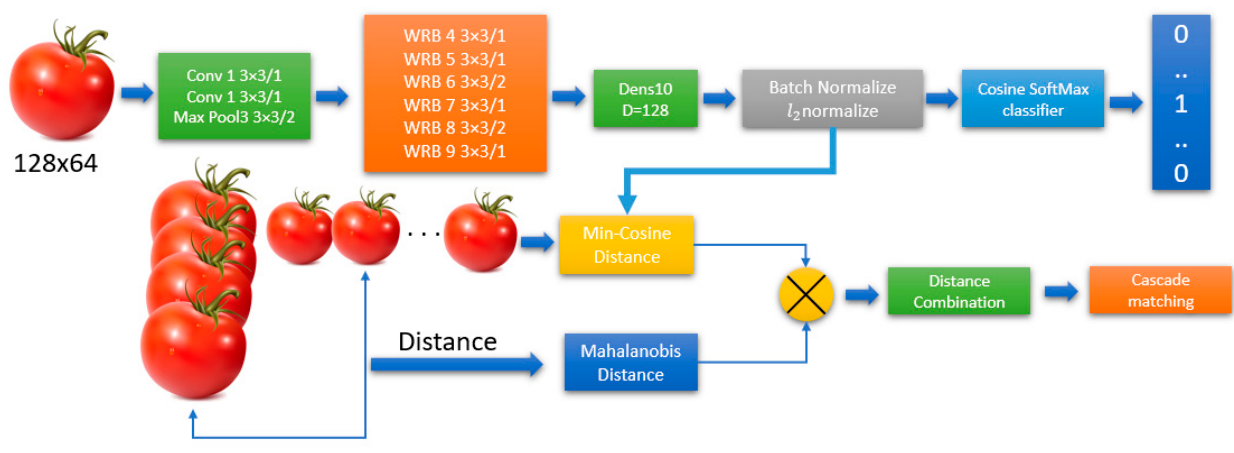
Figure 2. Deep Sort Algorithm.